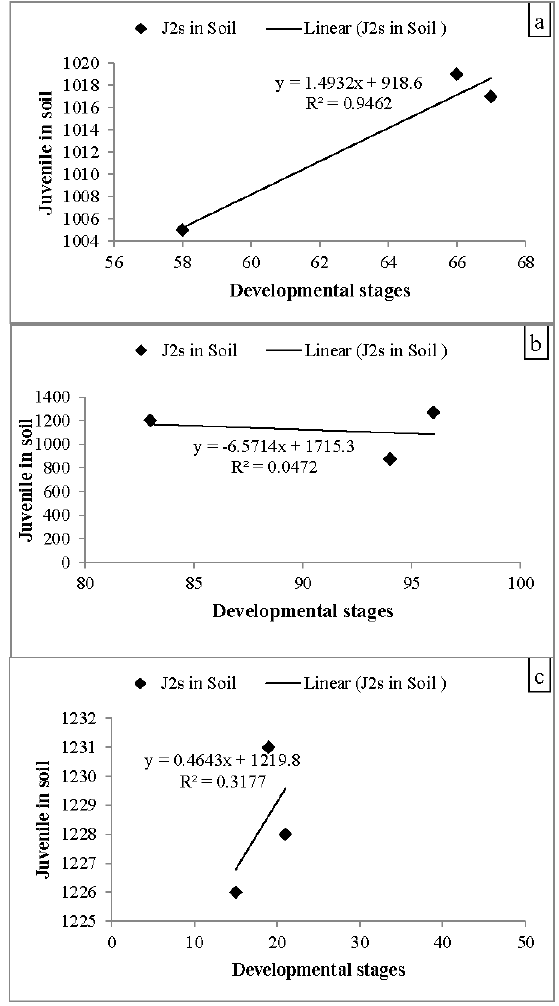
Figure 5. Correlation and regression equations juvenile in soil and developmental stages that suc- ceeded in penetrating the roots, were shows ( a ) positive and significant strong correlation in treated by mycorrhizal fungi (r = 0.973), while ( b ), shows a negative correlation in treated by n-HAP (r=- 0.218). And ( c ) positive and significant medium correlation in treated by mycorrhizal fungi and n- HAP (r = 0.564).